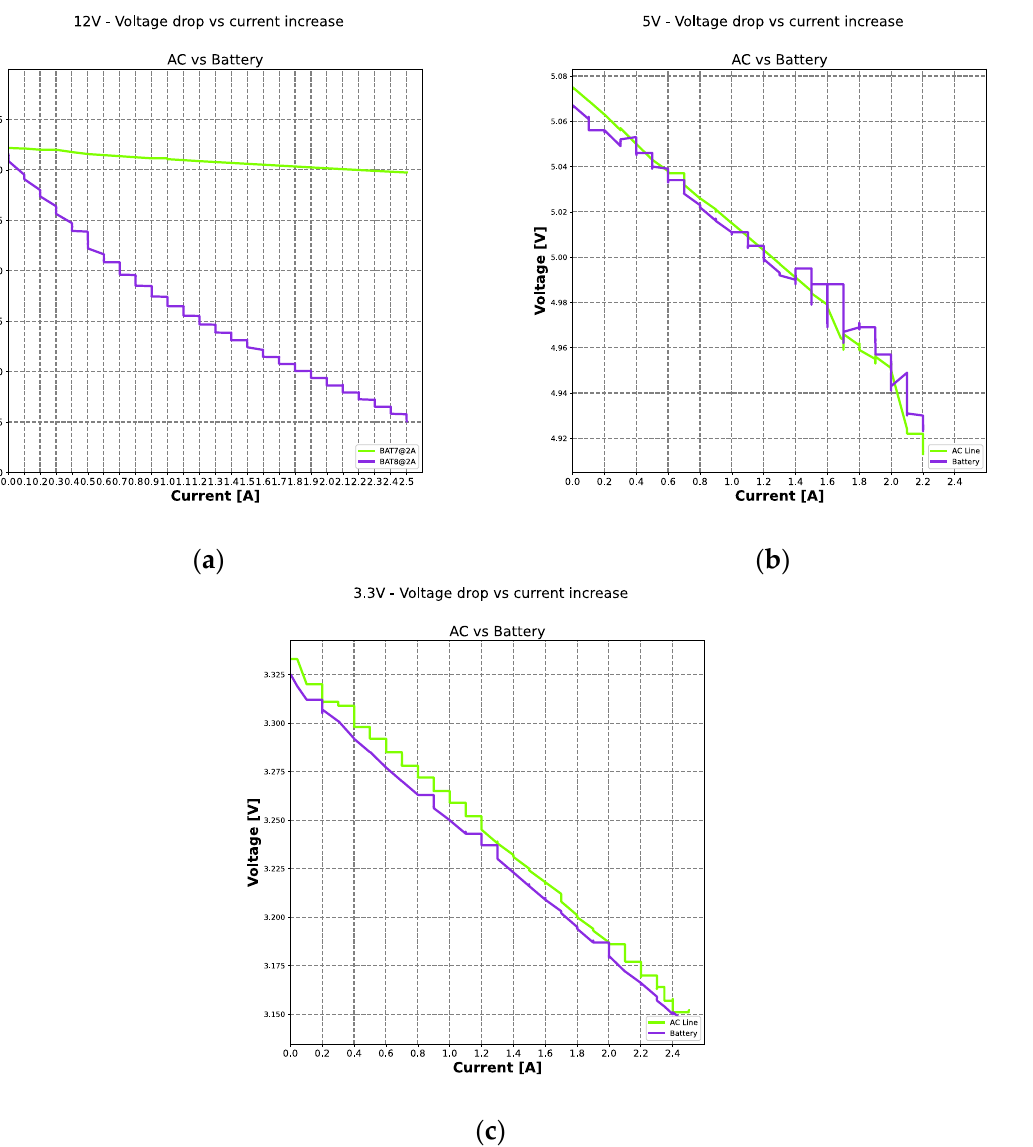
Figure 16. Voltage curve graphs: ( a ) Voltage vs. current—12 V, ( b ) Voltage vs. current—5 V, ( c ) Voltage vs. current—3.3 V.